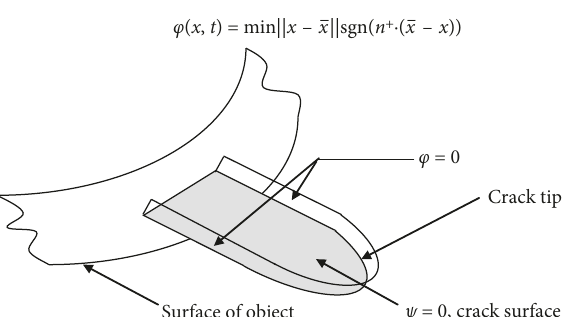
Figure 2: Plane cracks represented by two level set functions ψ and φ .